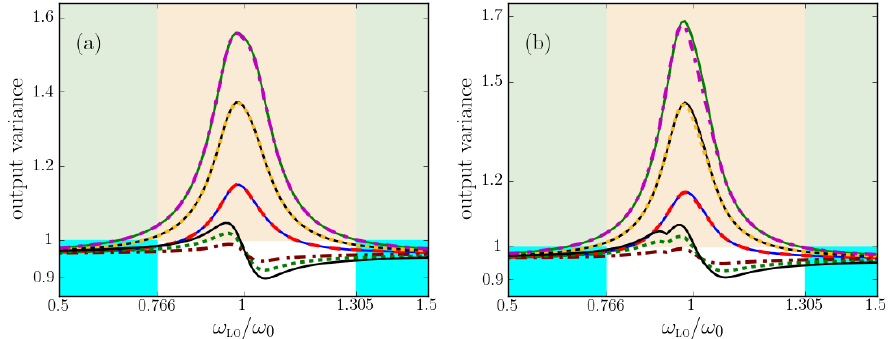
Figure 9. Same as Figure 7 but now for three different numbers of unit cells: M = 3,6,9, in panel ( a ) for s -polarized and in ( b ) for p -polarized light. The three lowest curves describe QOEI theory, with the largest variation belonging to M = 9. The three pairs of almost overlapping curves belong to M = 3 (lower pair), M = 6 (middle pair), and M = 9 (upper pair). Each pair contains the exact multilayer theory (solid lines) with QOEM theory (dashed